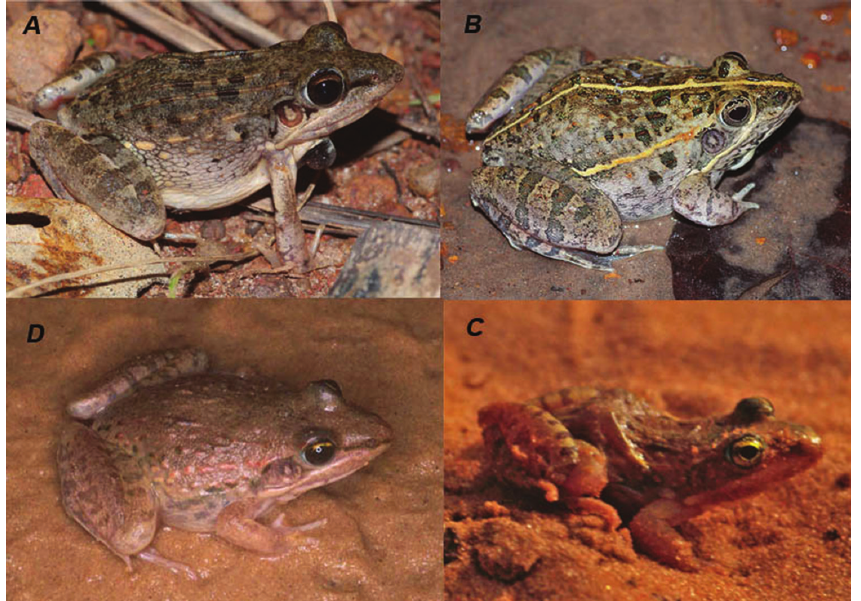
Figure 5. The four species of Ptychadena recorded in Mauritania: Ptychadena bibroni from Gourel Yoba, Senegal; male specimen, not collected ( A ), Ptychadena trinodis from Toubakouta, Senegal; male specimen, not collected ( B ), Ptychadena cf. mascareniensis from Zoueina, Mauritania (MNCN 41784, SVL=29.6 mm) ( C ), Ptychadena schillukorum from Aleg, Mauritania (MNCN 42214, SVL=31.8 mm) ( D ) [photos Alberto Sánchez Vialas ( A, B ), José Manuel Padial ( C ) and Rafael Márquez ( D